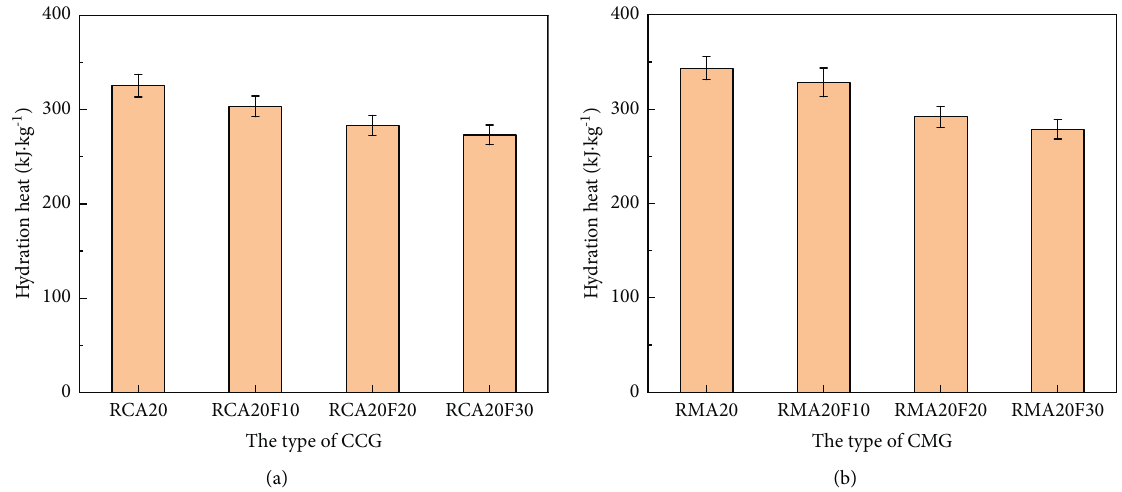
Figure 7: The hydration heat of CCG and CMG with different content of fly ash. (a) CCG, (b) CMG.